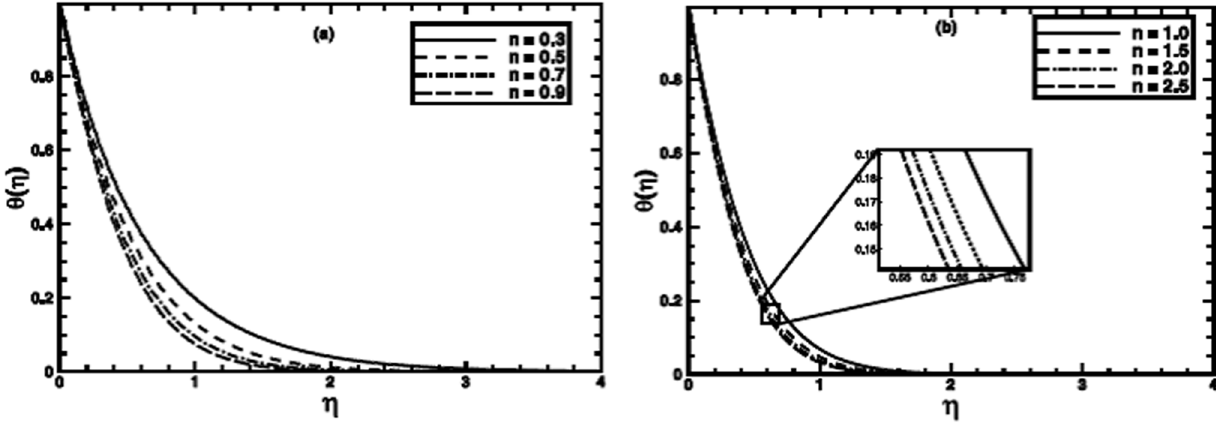
Figure 1. The temperature profile h g ð Þ in the PST case for different values of the power-law index n when s ~ 1 : 5 , Pr ~ 3, m ~ 1 and A ~ 1 are fixed.